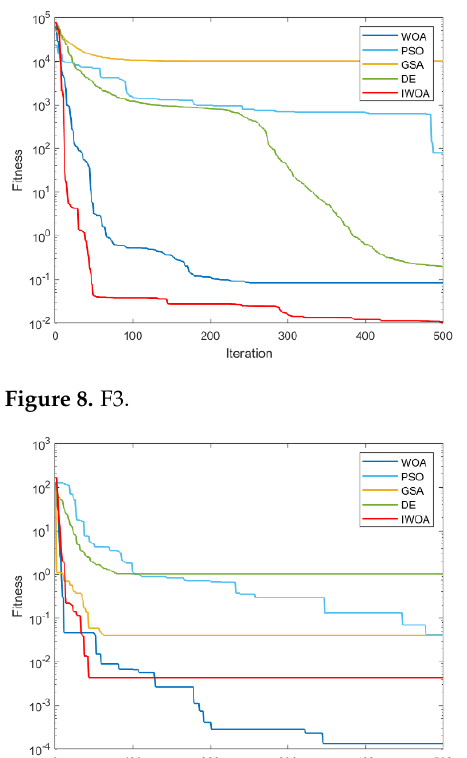
Figure 7. F2. Figure 7. F2.